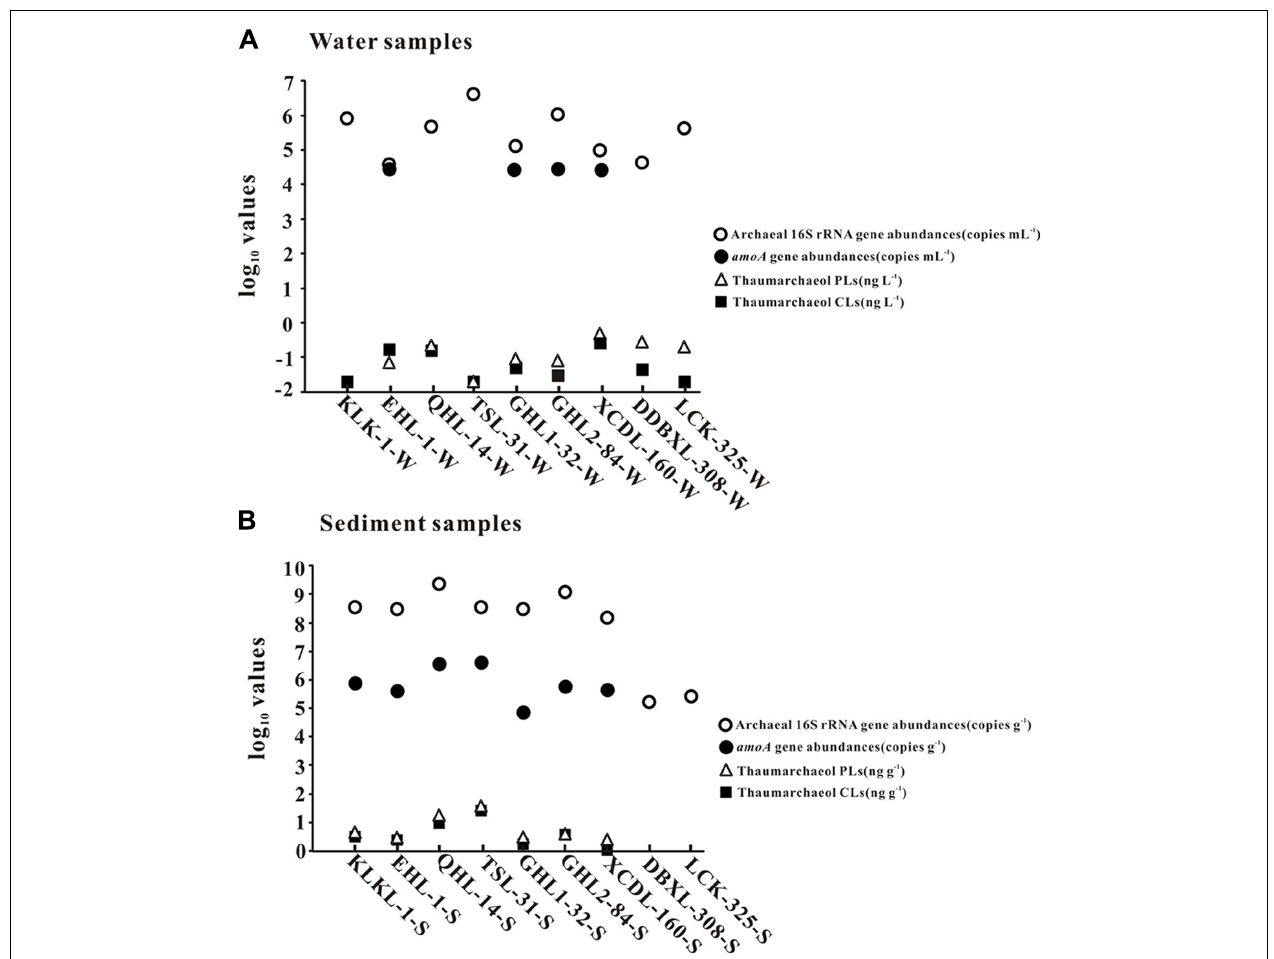
FIGURE 2 |The abundances (copies per gram of sediment or copies per milliliter of water) of total archaeal 16S rRNA and amoA genes and thaumarchaeol concentrations (nanogram per liter of water and nanogram per gram of sediment). Panels (A) and (B) are for waters and sediments, respectively.